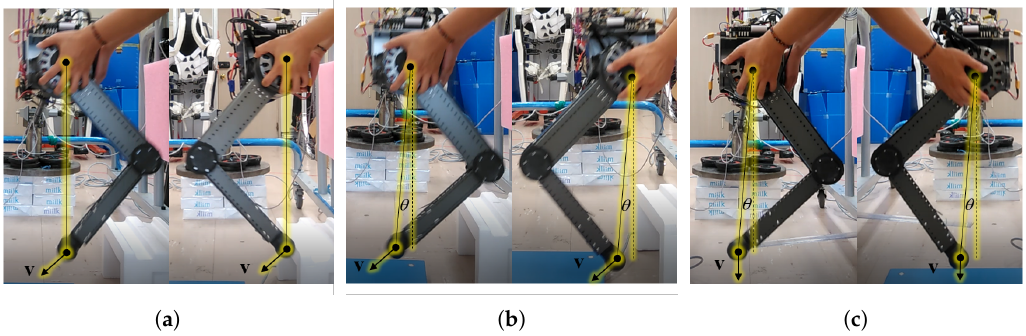
Figure 14. Impact experiment for backward/forward flexion: ( a ) l n = 0.75, θ = 0 ◦ , and ∠ v = ∼ 30 ◦ , ( b ) l n = 0.75, θ = 8 ◦ , and ∠ v = ∼ 30 ◦ , and ( c ) l n = 0.75, θ = 8 ◦ , and ∠ v = ∼ 0 ◦